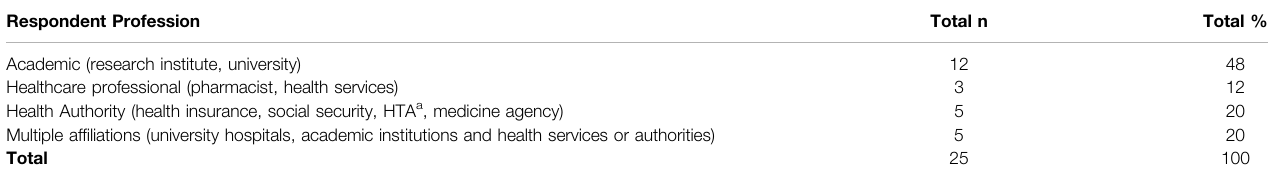
TABLE 2 | Respondent breakdown by professional setting.